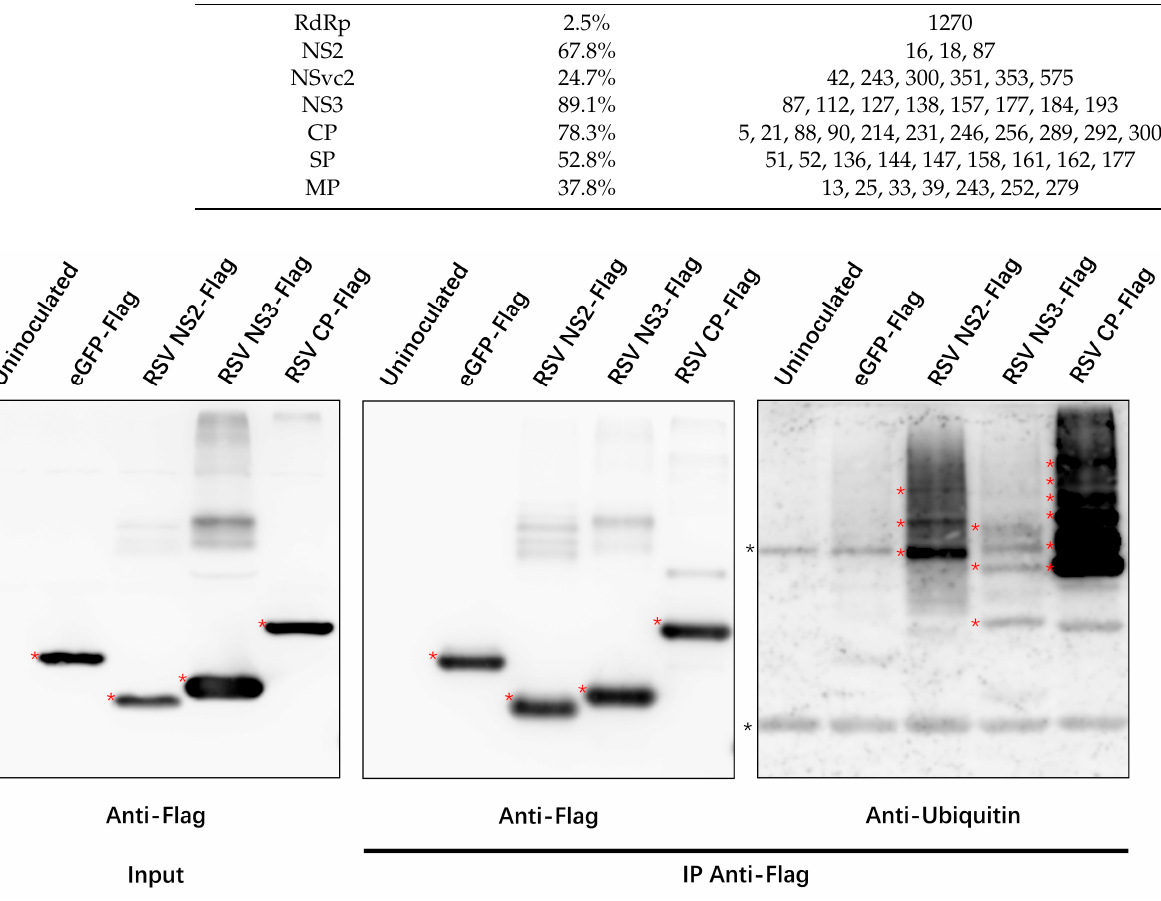
Figure 6. Immunoprecipitation of ubiquitinated RSV proteins in N. benthamiana . eGFP-Flag, RSV- NS2-Flag, RSV-NS3-Flag and RSV-CP-Flag were transiently expressed in N. benthamiana leaves, respectively. Anti-Flag magnetic beads were used to affinity enrich proteins with Flag tag. Antibody against Flag tag was used to analyze samples before (Input) and after (IP) immunoprecipitation. The bands with red asterisks on the left two images represent the corresponding protein bands. Antibodies against ubiquitin were used to analyze samples after IP. The red asterisks on the right image represent ubiquitinated RSV proteins. Black asterisks referred to the heavy and light chains of beads. The molecular weight was indicated on the